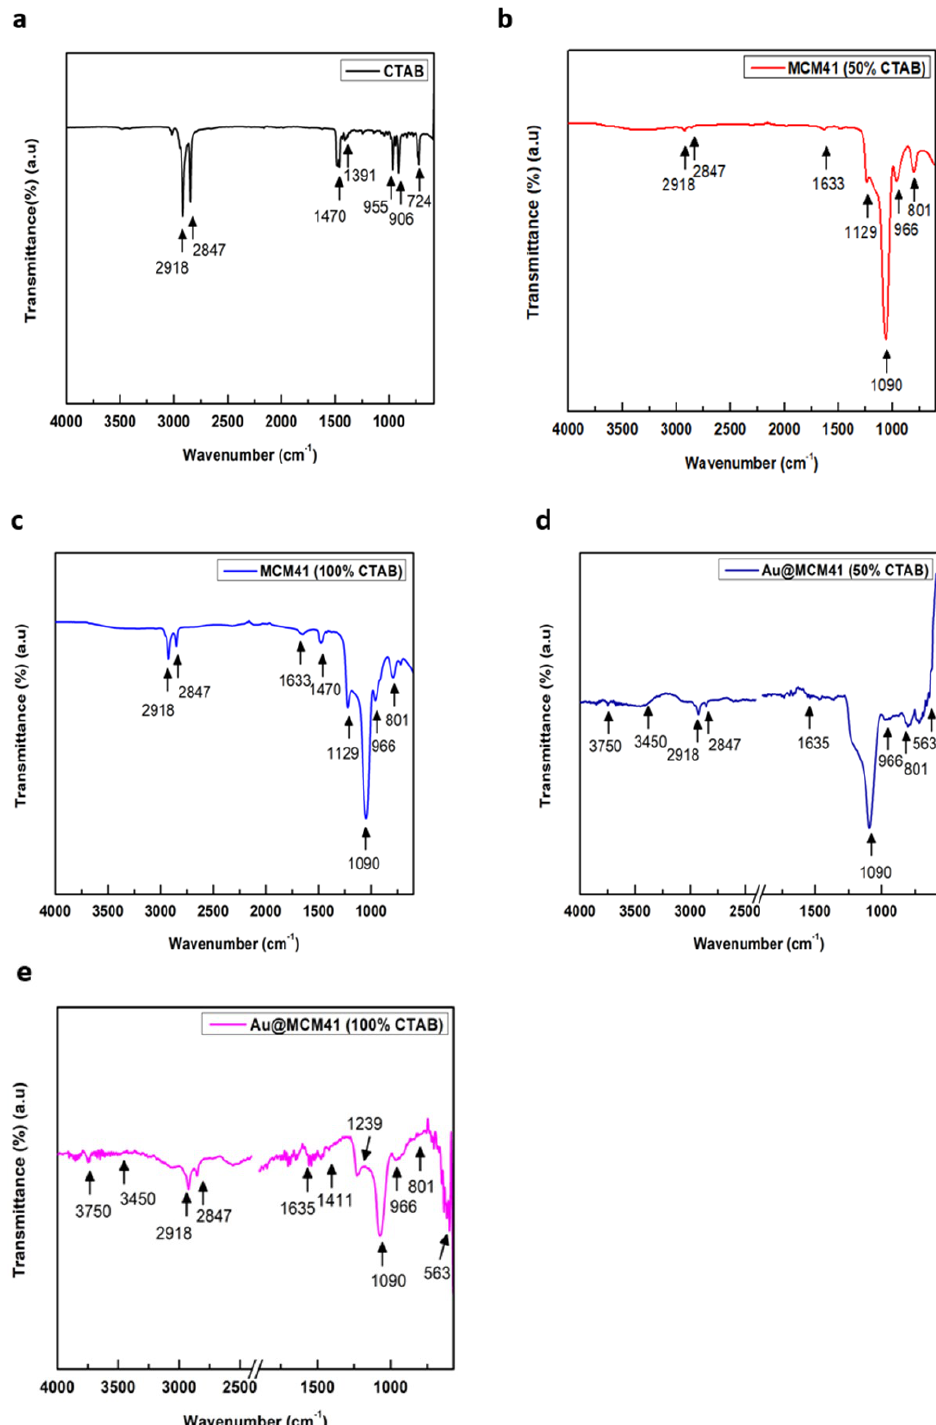
Figure 5. FTIR spectra of ( a ) CTAB surfactant only; ( b ) MCM-41 (50% CTAB); ( c ) MCM-41 (100% CTAB); ( d ) Au–MCM-41 (50% CTAB); and ( e ) Au–MCM-41 (100% CTAB).